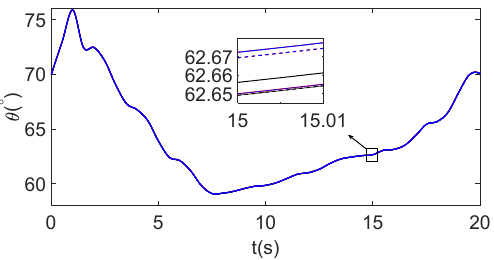
Figure 16. Pitch angle in the Monte Carlo simulation.